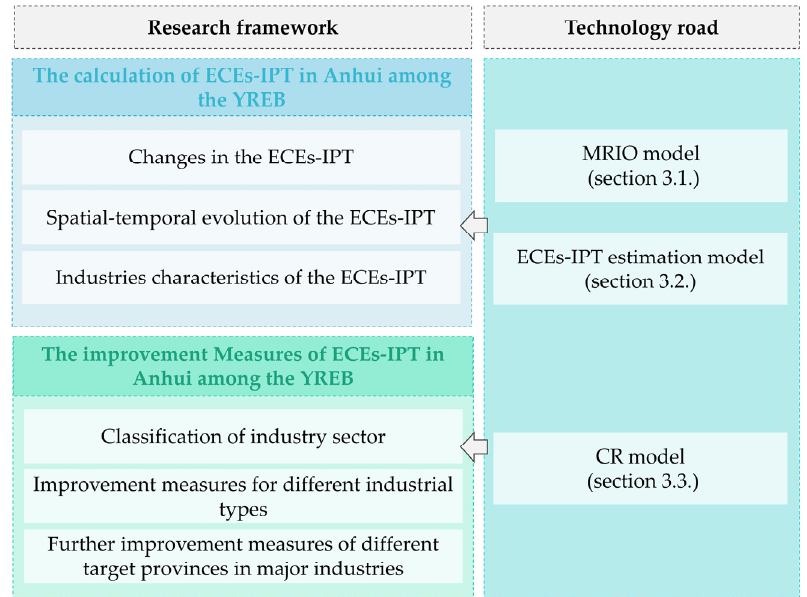
Figure 4. The map of research framework and technology road.